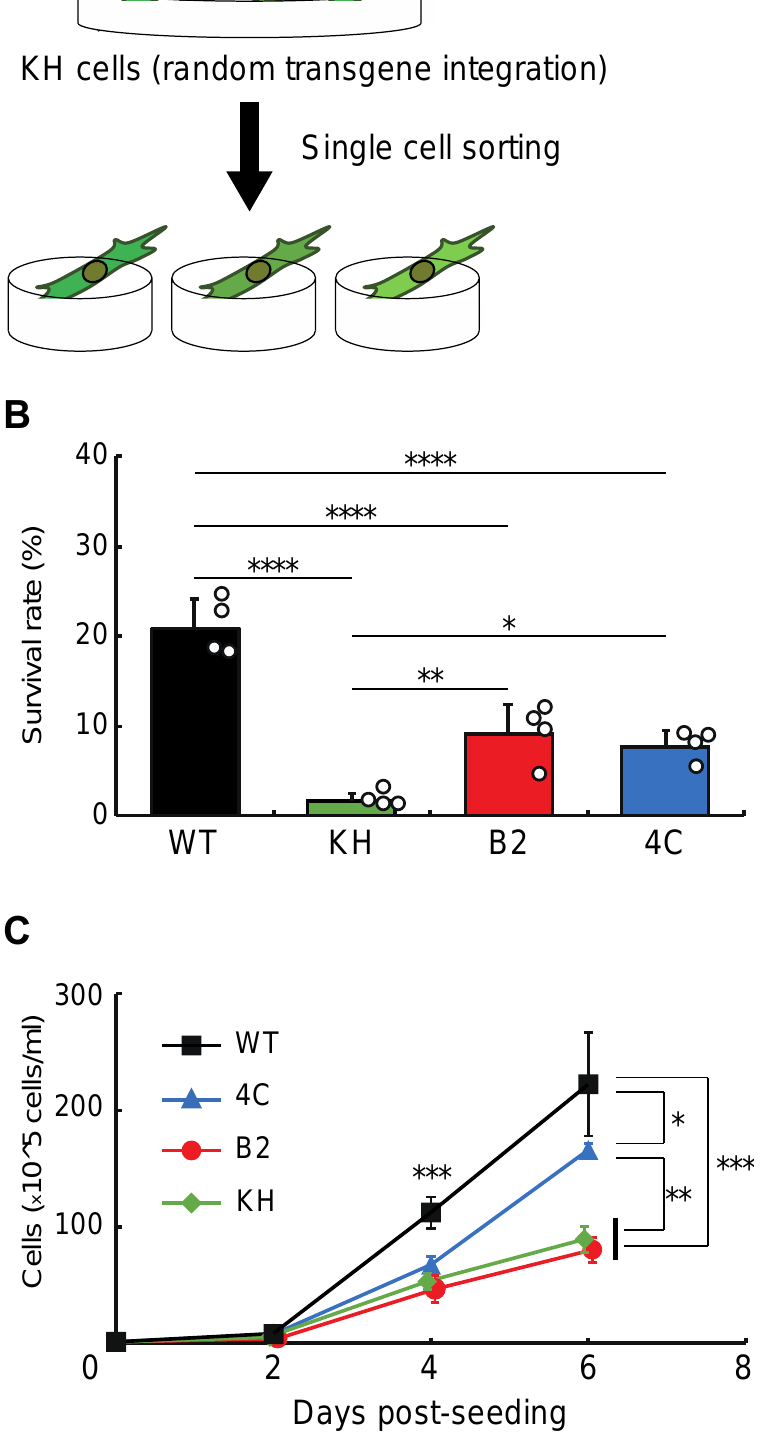
Figure 1. Selection of clonal cell lines from the KH cell pool. ( A ) The experimental scheme is shown. To establish clonal cell lines from KH cells, single-cell sorting was performed. ( B ) The survival rates after desiccation – rehydration treatment of the clonal cell lines, B2 and 4C, are shown. ( C ) The proliferation rates of the B2 and 4C cell lines are shown. Values are expressed as mean ± standard deviation (SD); n = 4 in each group. **** p < 0.0001; *** p < 0.001; ** p < 0.01; * p < 0.05.